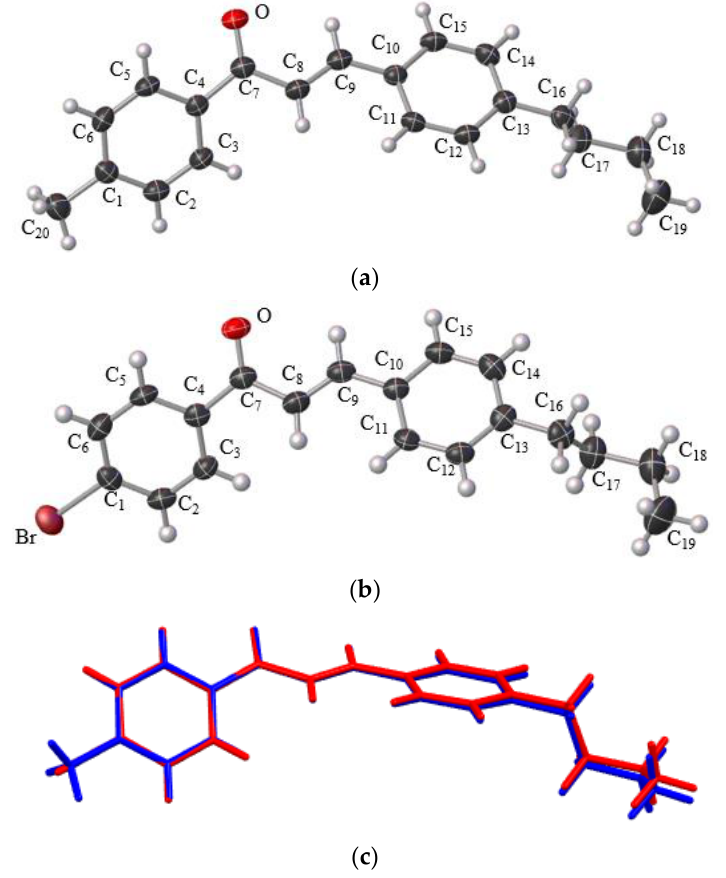
Figure 2. Ortep diagram showing ( a ) BMP and ( b ) BBP chalcones in the asymmetric unit drawing with 75% probability ellipsoid. ( c ) Overlap of BMP (in blue) e BBP (in red) chalcones molecular structures (RMS = 0.0198 Å ). Table 1. Crystallographic data and structure refinement for BMP and BBP.